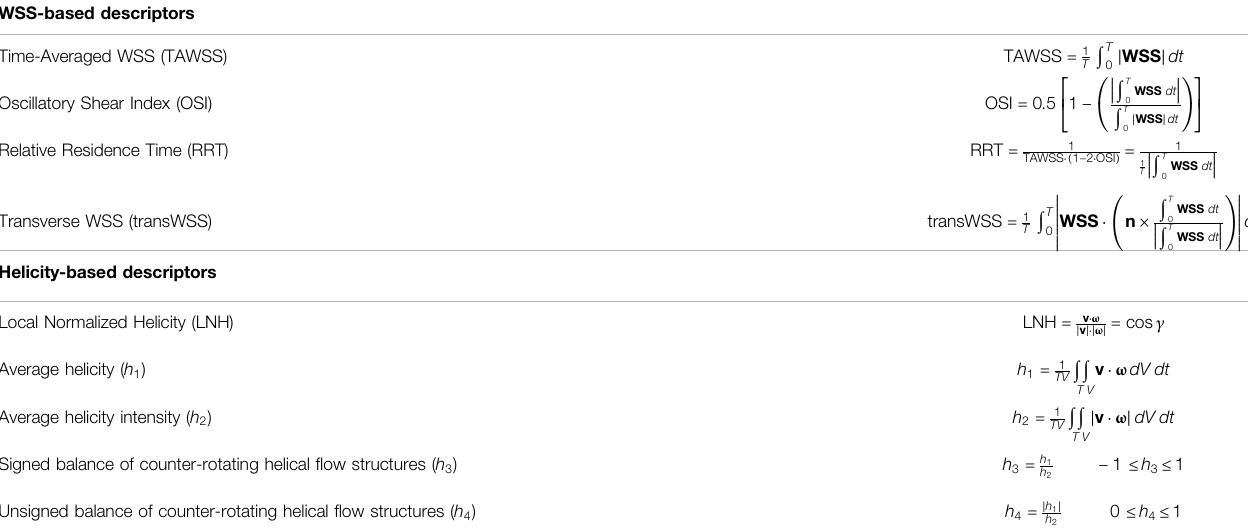
TABLE 2 | - De fi nition of hemodynamic descriptors involved in the analysis.